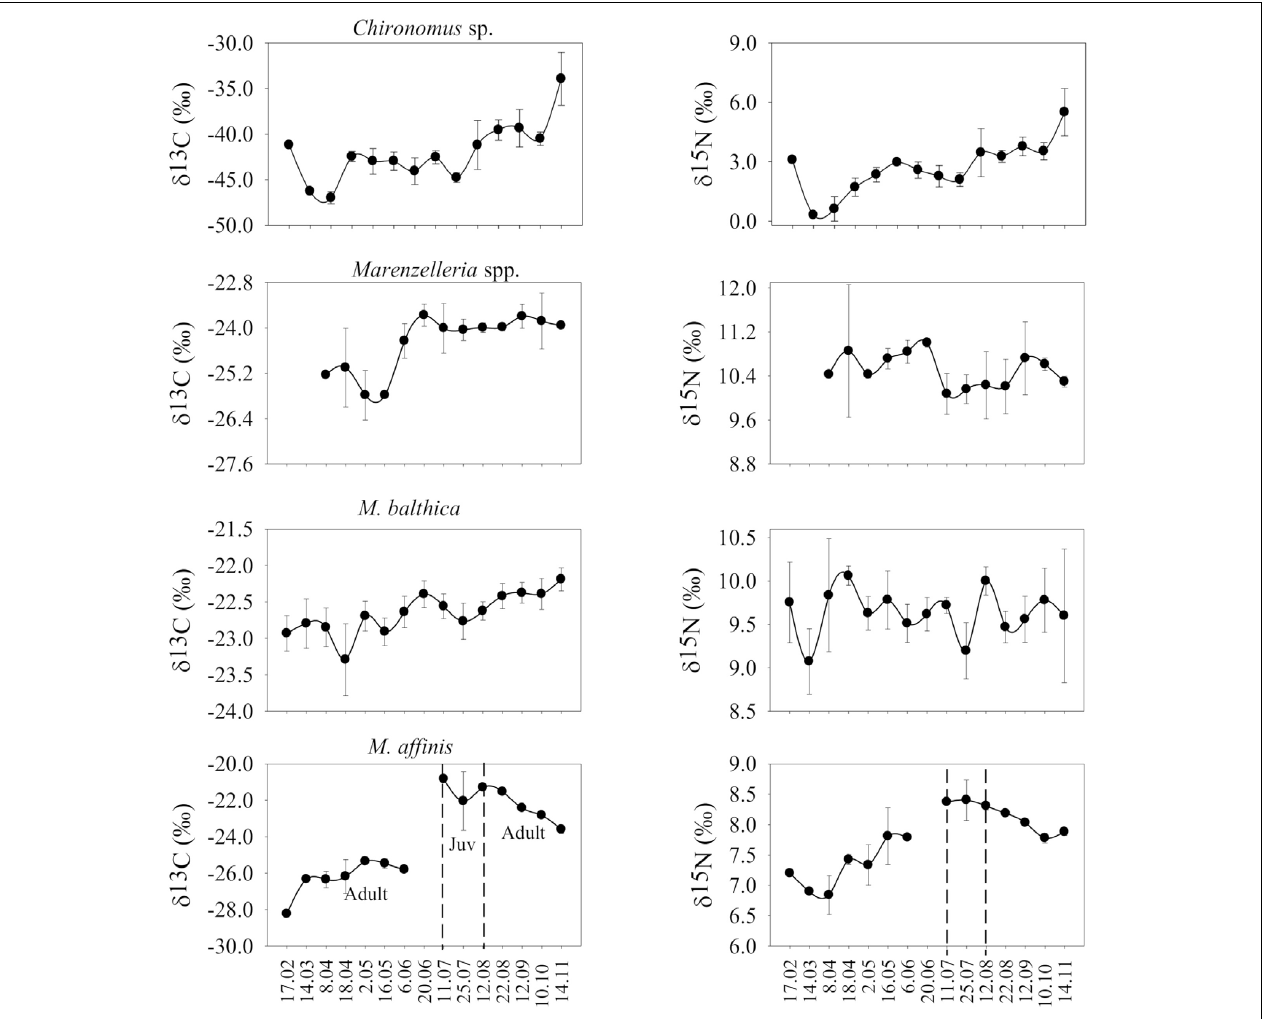
FIGURE 6 | Mean ( ± sd) values of the stable isotope δ 13 C signals estimated from the four benthic macroinvertebrate species (deposit feeders: Chironomus spp., Marenzelleria spp., Macoma balthica , and Monoporeia affinis in adult and juvenile stages) sampled over time (February to November